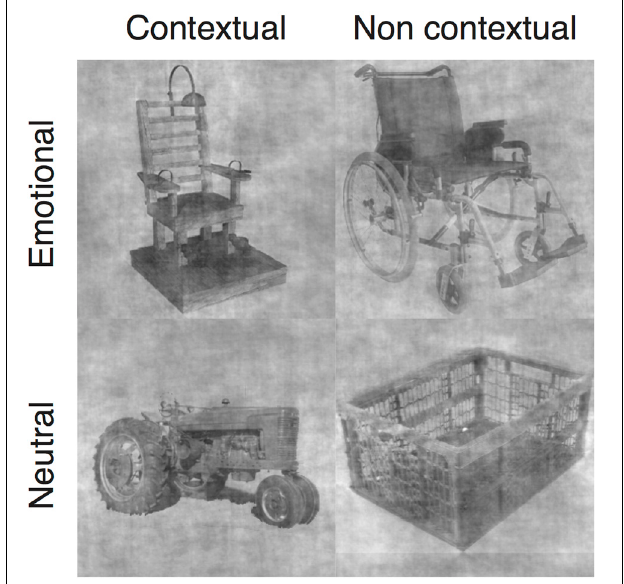
FIGURE 1 | Example images for each of the four categories of